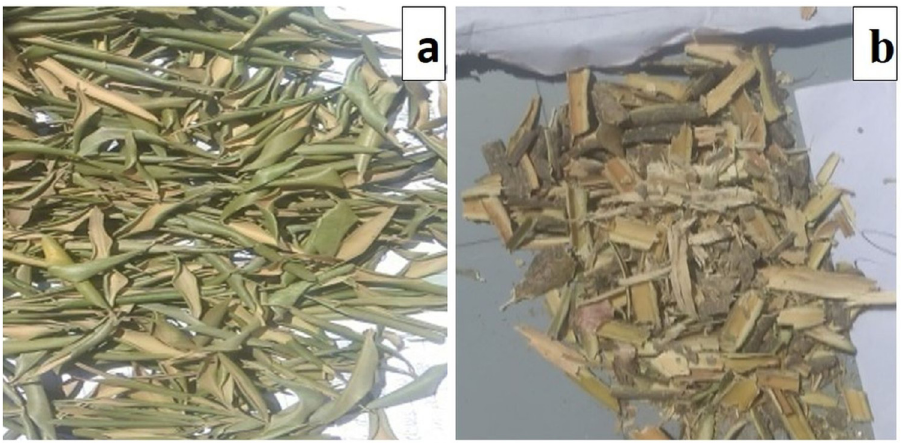
Figure 1: Plant parts of O. ferruginea : ( a ) leaves and ( b ) bark, used for the synthesis of Ag